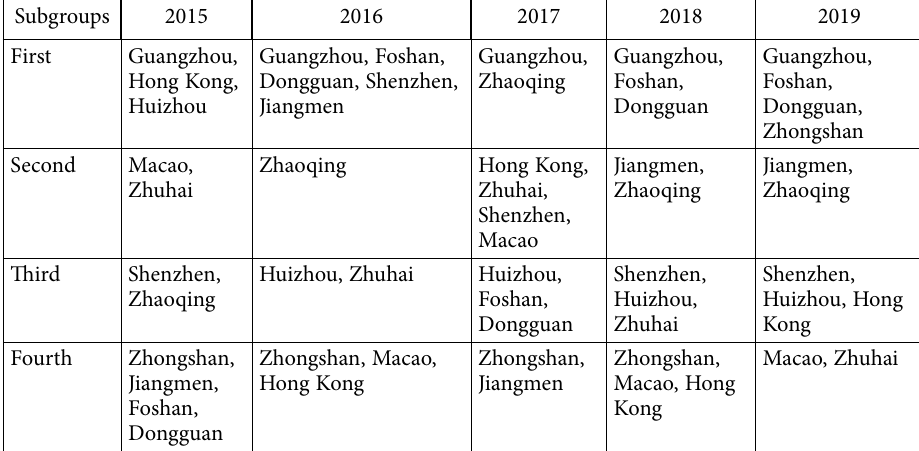
Table 6. Division of cohesive subgroups of the GBA’s green development spatial association network